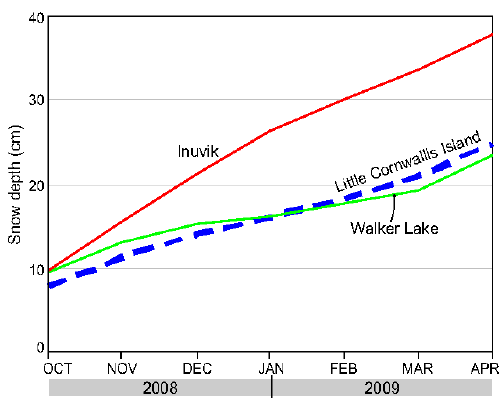
Figure 12. Location of biomass fires in Eurasia based on the MODIS Fire Mapper (Giovanni program) for October-November of 2008. The resolution of the fire radiative power field is 1 ° × 1 ° .